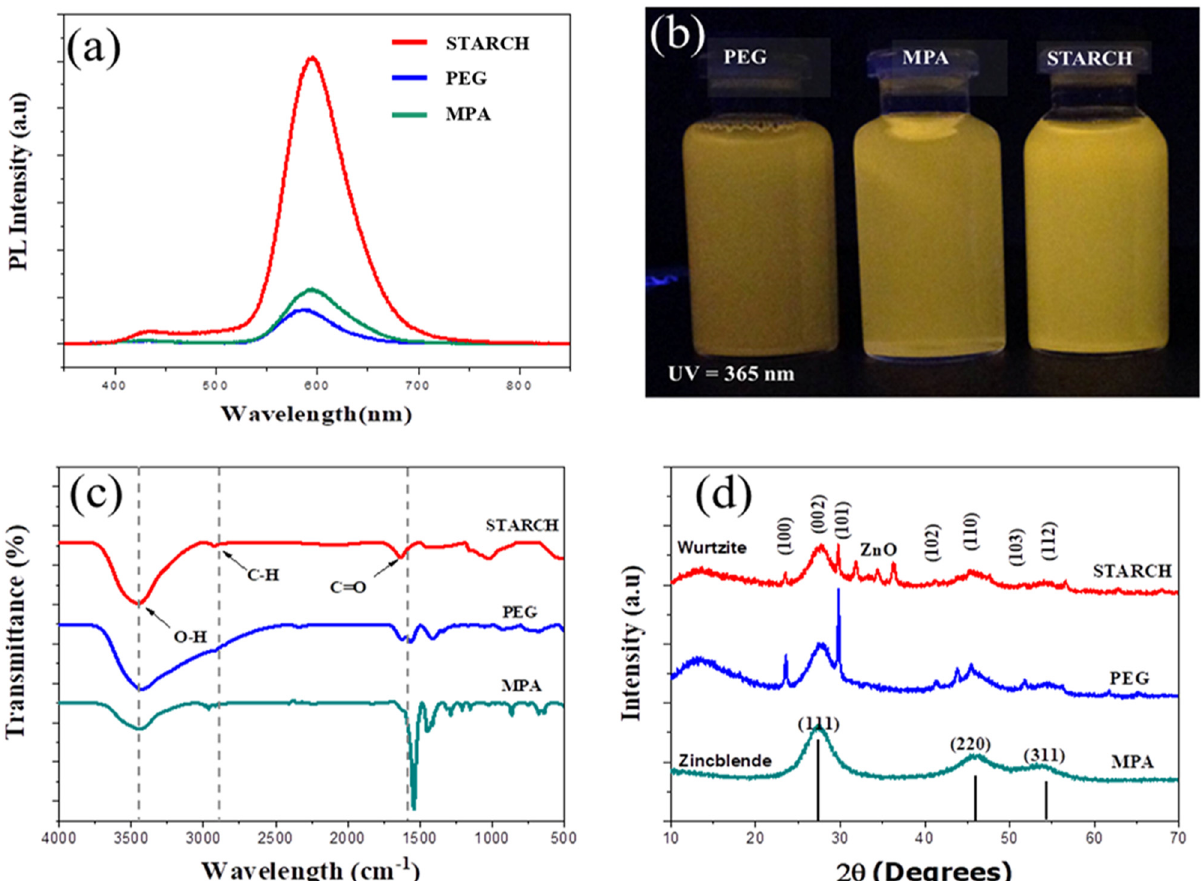
Figure 2: The characteristics of ZnSe:Mn ( 5% ) with various capping agents, ( a ) PL spectra, ( b ) photographs of ZnSe:Mn solution were irradiated by UV ( 365 nm ) , ( c ) FTIR spectra, and ( d ) XRD